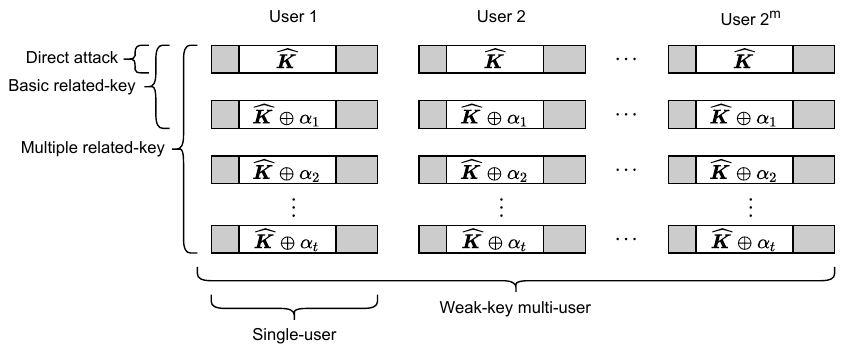
Figure 7: Examples of keys in the direct attack, basic related-key and multiple related-key settings, where each setting can be either single-user or weak-key multi-user. Note the additional assumption that the attacks are not done in the uniform standard model, as some bits of these keys must fulfill the same XOR relation. The white parts represent the XOR relation that each key owned by these users must fulfill; the grey parts are the other secret key bits which can be drawn uniformly at random but must be different within the same